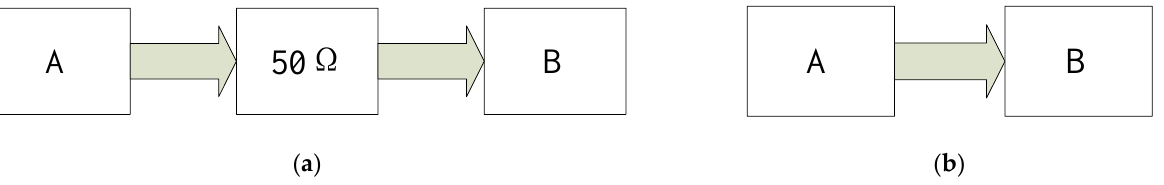
Figure 9. Impedance transform diagram: ( a ) indirect change; ( b ) direct change.